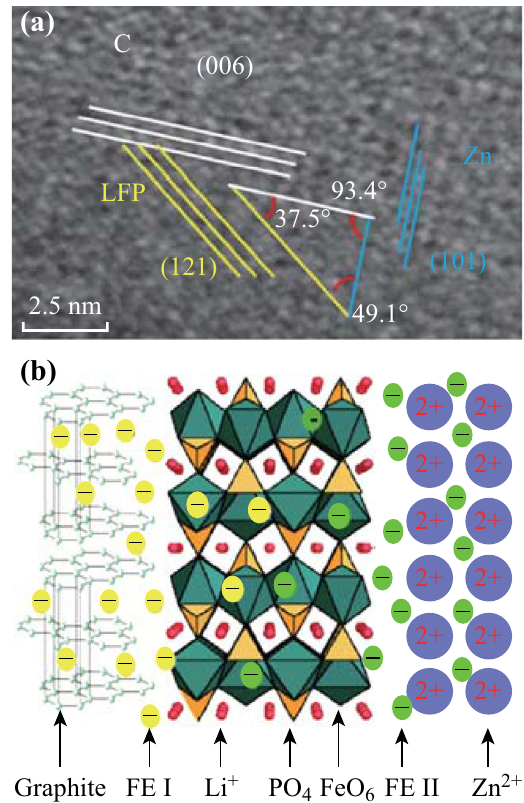
Fig. 2 a An enlarged TEM image of LFP/C ZIF-8 . b The mechanism of conductivity improvement, FE I represents free electron in graphite, FE II is free electron in metal